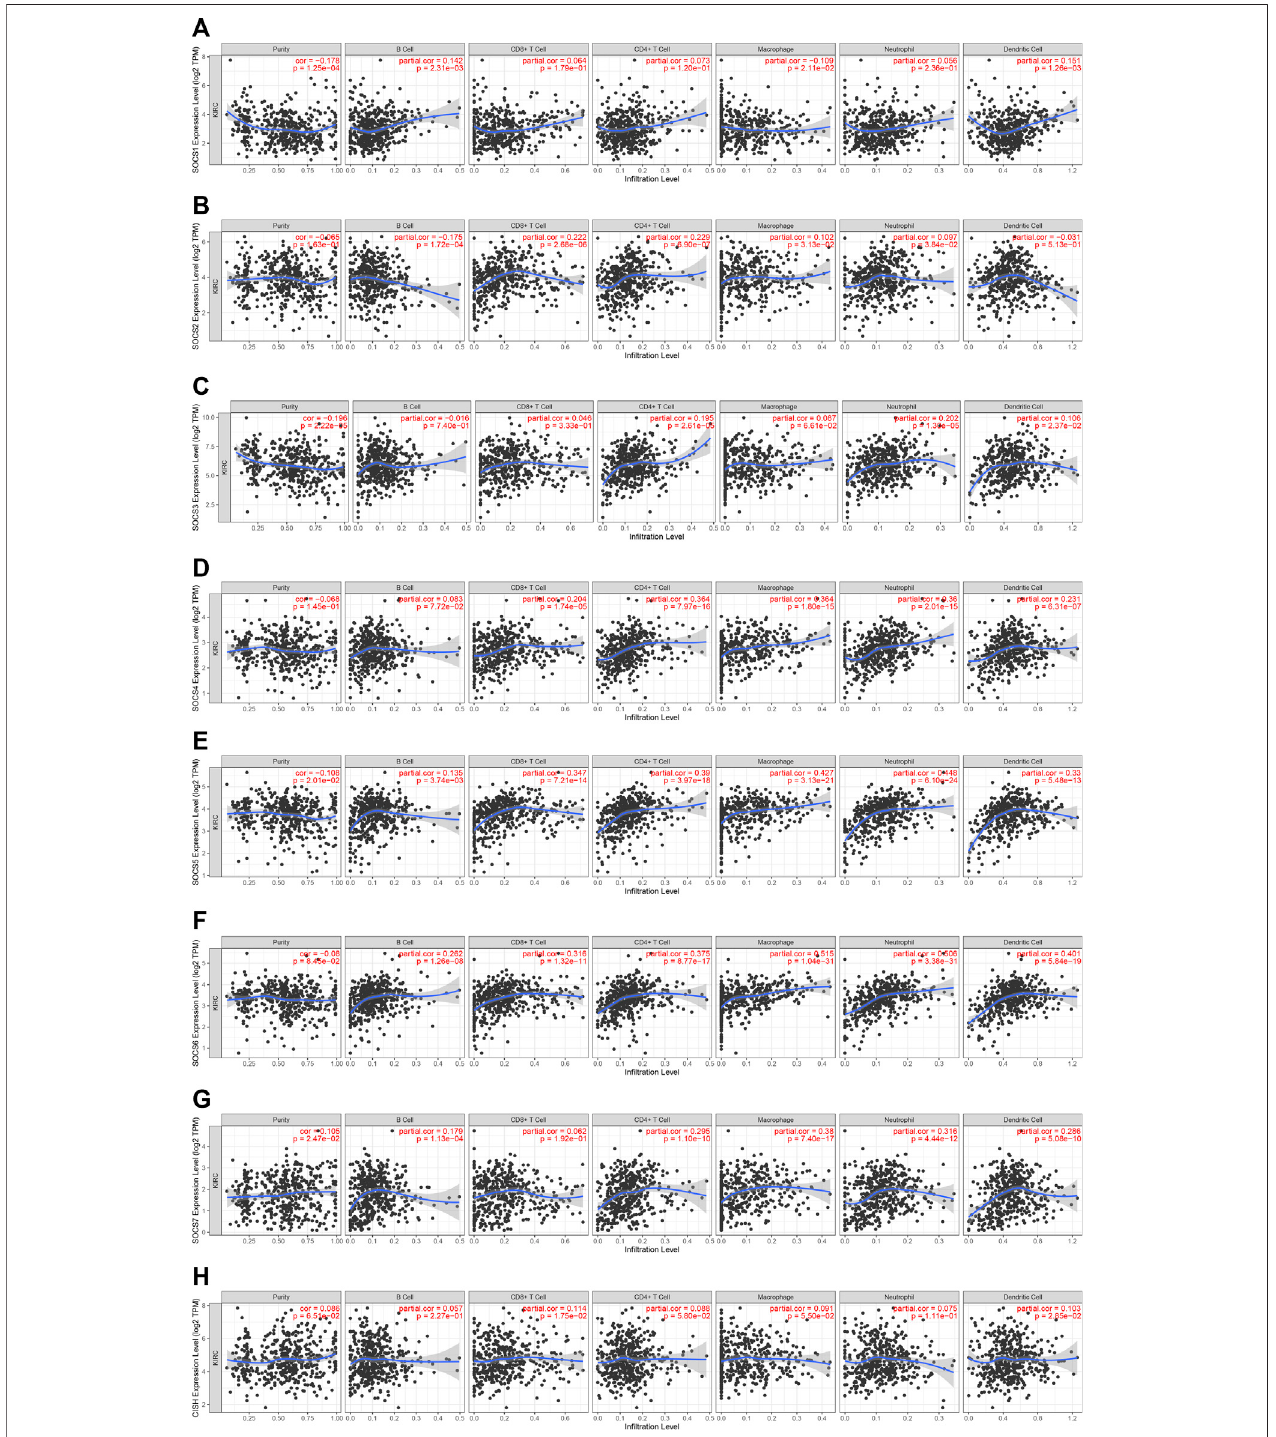
FIGURE6 | CorrelationofSOCS expression with immunein fi ltration level in KIRC. (A) SOCS1 expression waspositivelyassociated within fi ltrationofdendriticand B cells. (B) SOCS2 expression was positively associated with in fi ltration of CD8 + T cells, CD4 + T cells, macrophages, and neutrophils and negatively associated with in fi ltration of B cells. (C) SOCS3 expression was positively associated with in fi ltration of CD4 + T cells, neutrophils, and dendritic cells. (D) SOCS4 expression was positively associated with in fi ltration of CD8 + T cells, CD4 + T cells, neutrophils, dendritic cells, and macrophages. (E, F) SOCS5 and SOCS6 expression were positively associated within fi ltrationof all sixtypes ofimmunecells. (G) SOCS7 expression was positively associated with in fi ltration ofB cells, CD4 + T cells, neutrophils, dendritic cells, and macrophages. (H) CISH expression was positively associated with in fi ltration of CD8 + T cells and dendritic cells.